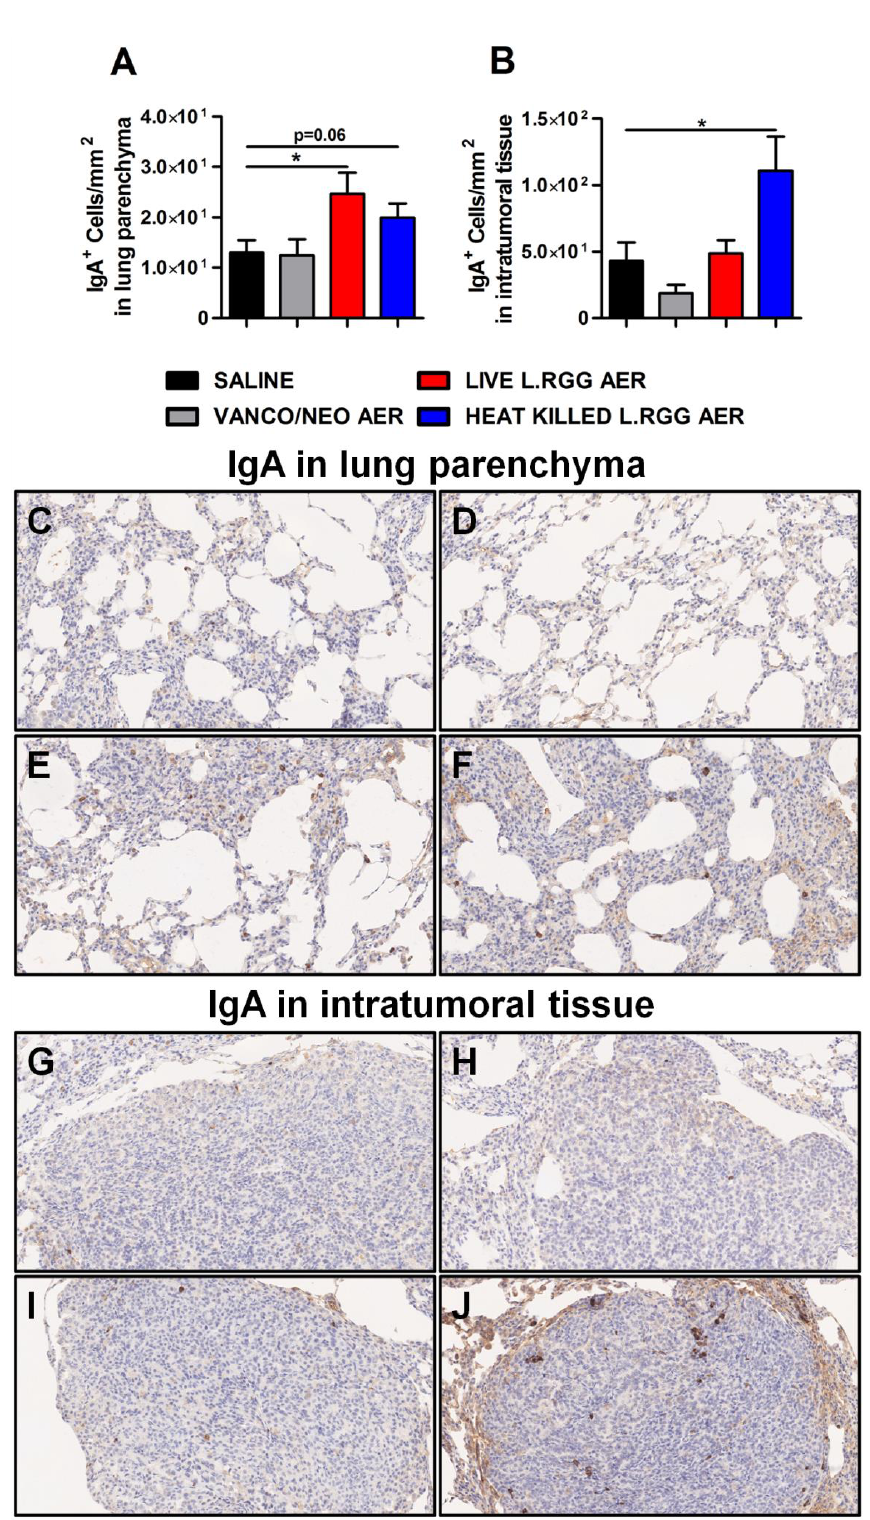
Figure 4. Impact of antibiotics and probiotic aerosolization on humoral immune response in the lung. Lung parenchyma ( A ) and intratumoral tissue ( B ) IgA protein level in formalin-fixed, paraffin- embedded lung specimens evaluated by IHC. Data are expressed as positive cells/mm 2 (4 sec- tion/lung, 8–9 mice/group) (mean ± SEM). Lung parenchyma and intratumoral tissue representative staining with anti-human/mouse IgA antibody in saline- ( C , G ), vanco/neo- ( D , H ), live L.RGG- ( E , I ) and heat-killed L.RGG- ( F , J ) treated lungs are shown; 20 × magnification. * p ≤ 0.05 by unpaired Student t